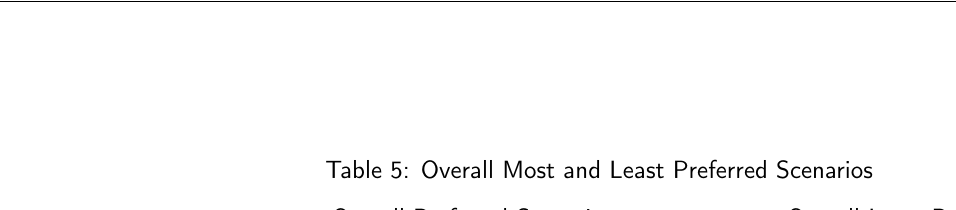
Table 5: Overall Most and Least Preferred